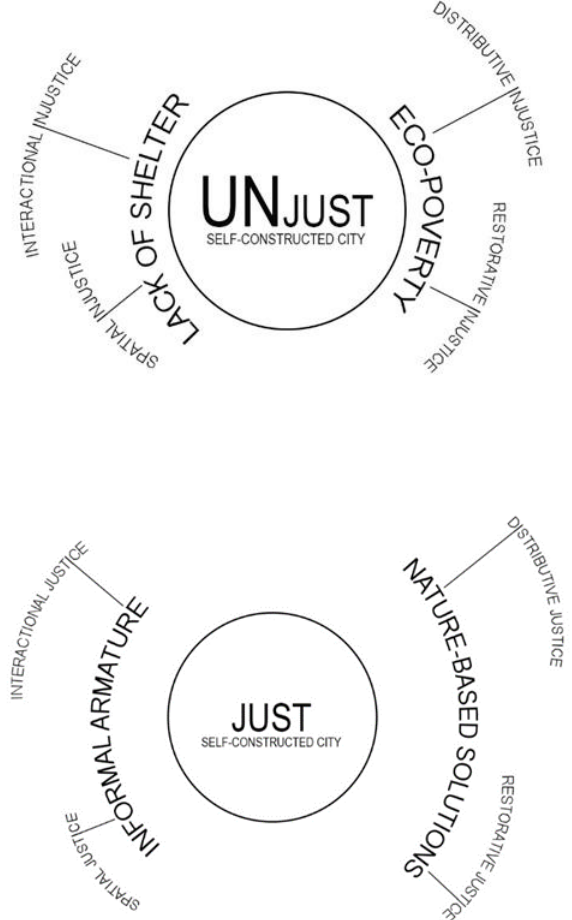
Figure 3. Shifting from Unjust to Just Self-constructed cities- main problems and leading solutions.